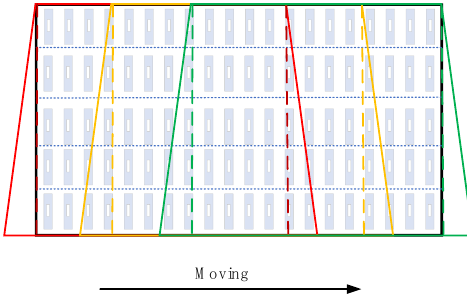
Figure 5. Optimization of identification range.